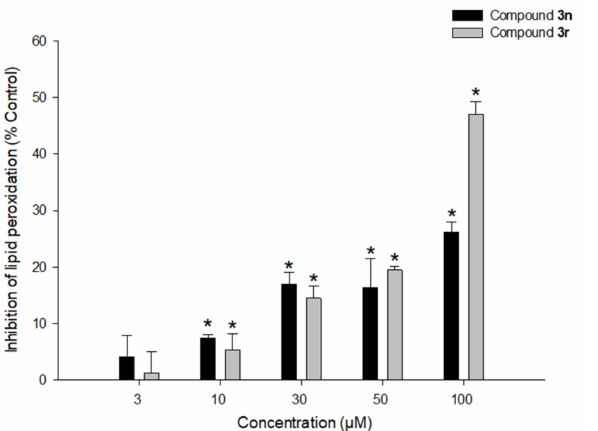
Figure 14. Effects of compounds 3n and 3r on LPO. Inhibition of LPO caused by Fe 2+ (10 µ M) and L-ascorbic acid (100 µ M) in rat forebrain homogenates by the tested compounds at the indicated concentrations were measured as described in the Materials and Methods section. Each data point represents the mean ± SEM from at least three independent experiments conducted in duplicate (* p < 0.05 vs. LPO measured in the absence of the test